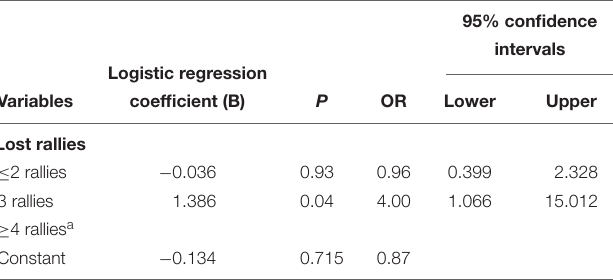
TABLE 3 | Model of binary logistic regression in unbalanced